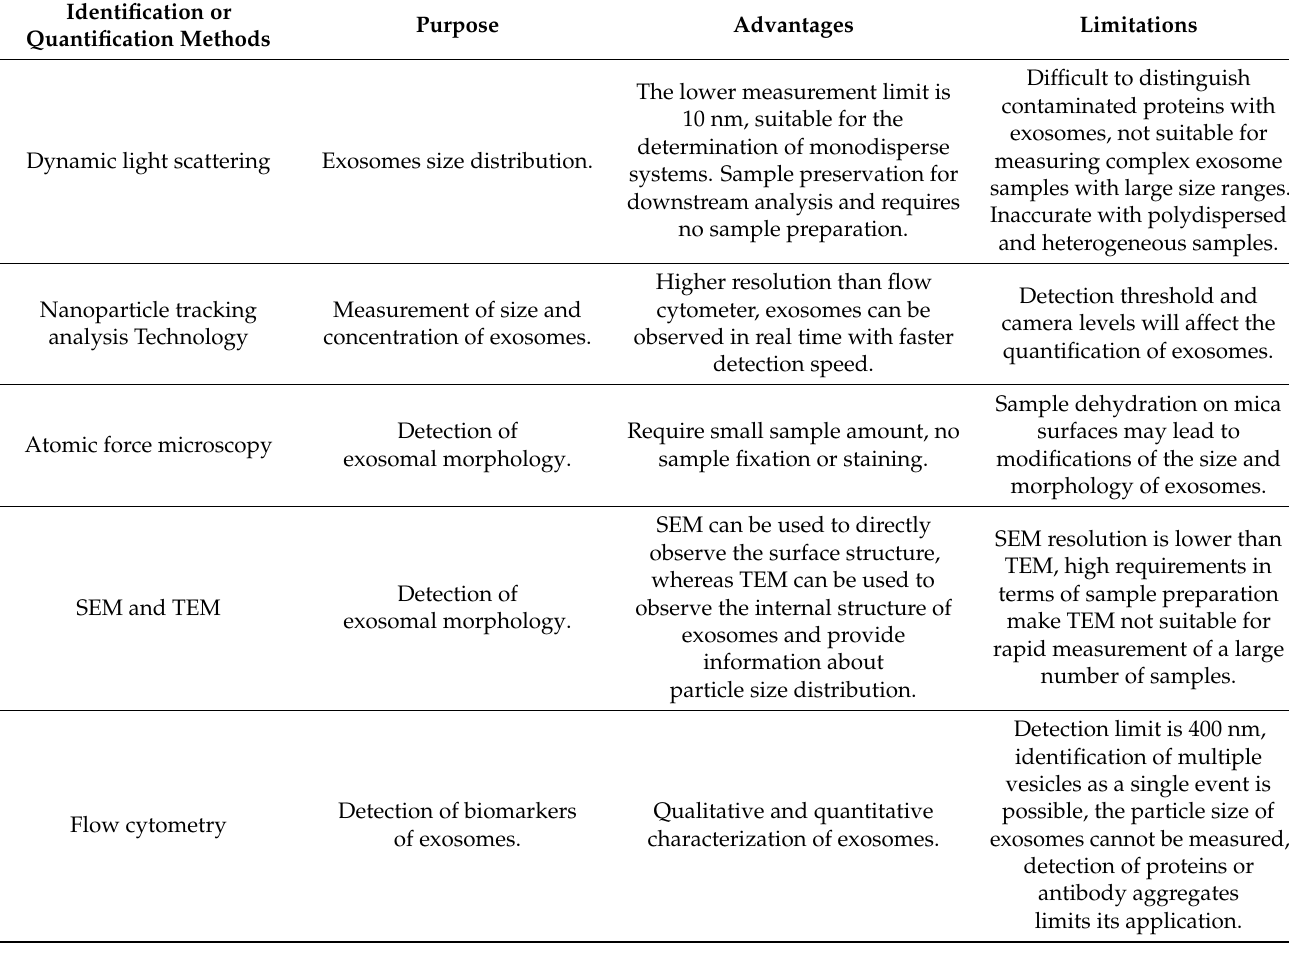
Table 5. Methods, advantages, and limitations of exosome characterization techniques [172,179,188,190–195]. Identification